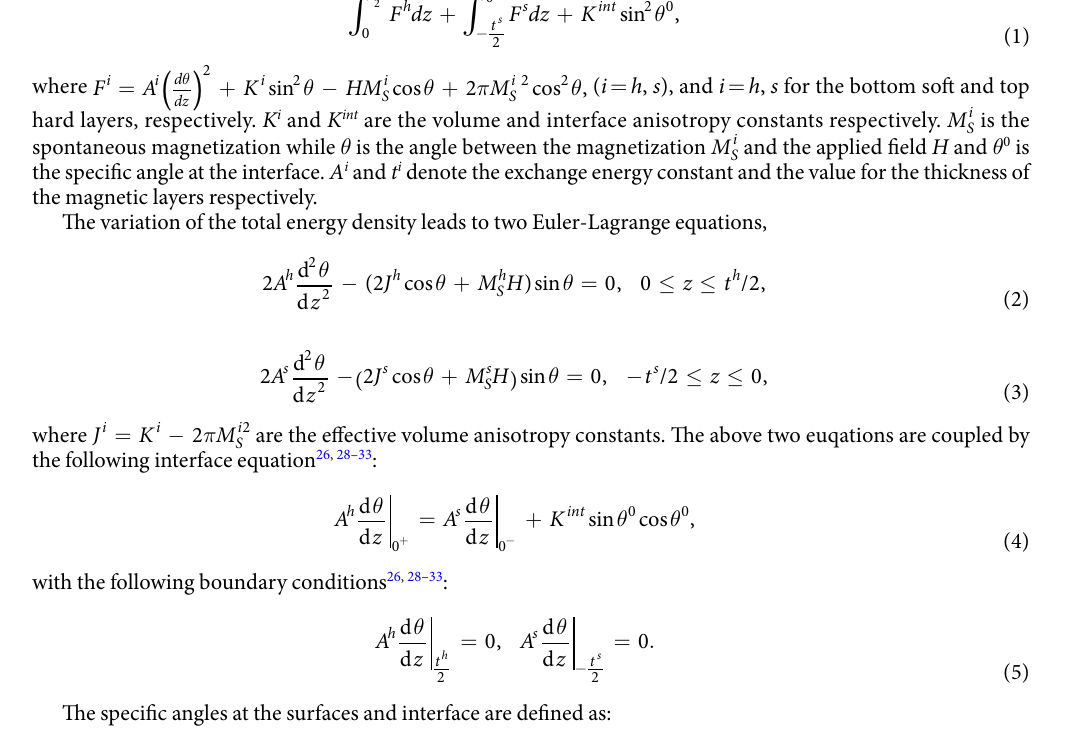
micromagnetic model. Their results indicate that the soft surface anisotropy has an evident effect on the nuclea- tion field, whilst the hard surface anisotropy has appreciable influence on the coercivity when the corresponding layer thickness is small. The impact of the interface anisotropy, on the other hand, is in between. For a hard/soft multilayer, the interface anisotropy is more important than the surface anisotropy because there are multi interfaces against only two surfaces. In this paper, the influence of both positive and negative interface anisotropies on the demagnetization process of a hard/soft multilayer system with a perpendicularly oriented anisotropy shown in Fig. 1 is studied. The nucleation field is found to be linearly related to the interface anisotropy, where the formula for the nucleation field is derived analytically. Both macroscopic and microscopic hysteresis loops have been calculated numerically, with angular distributions for the magnetizations and energy products given. Comparison of our results with experimental data indicates that the interface anisotropy should be taken into account in calculating nucleation fields and hysteresis loops.